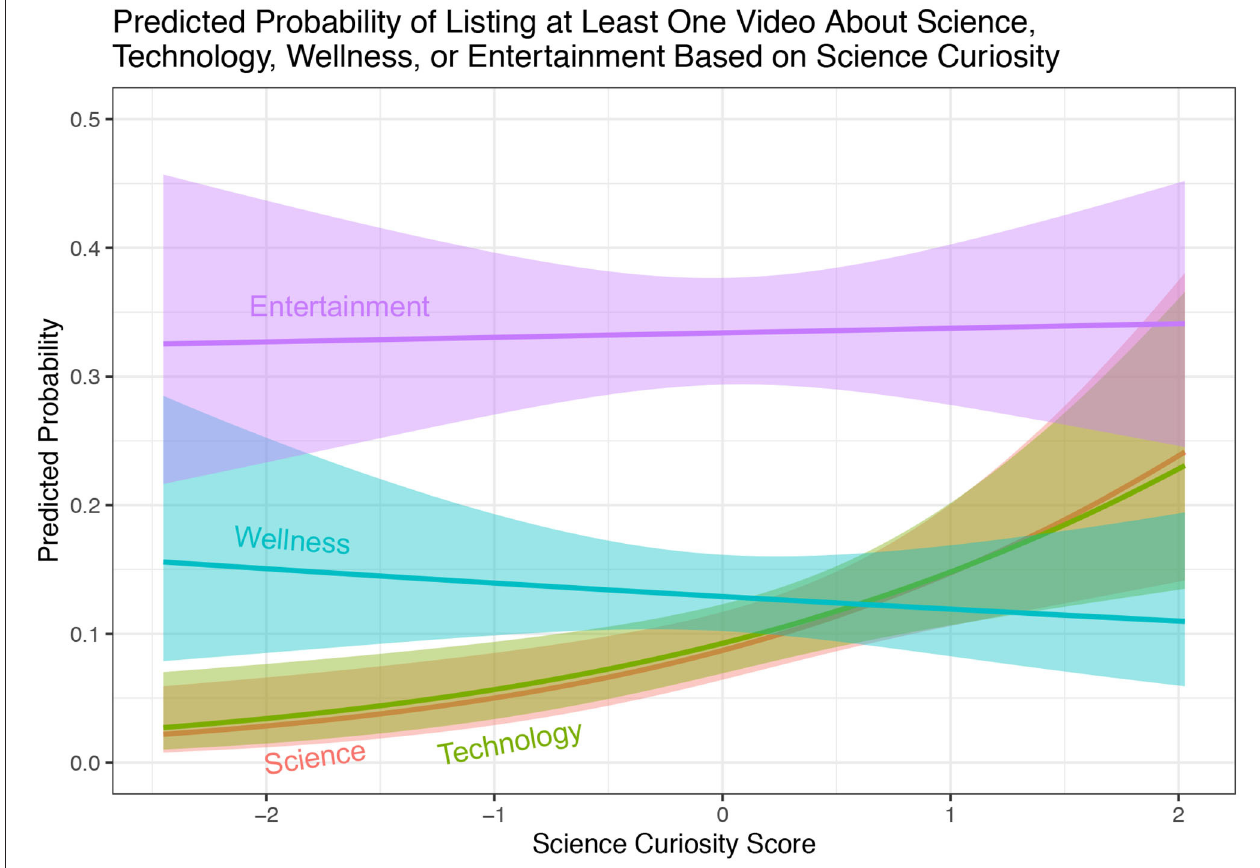
FIGURE 6 | Predicted probabilities of listing at least one of each video